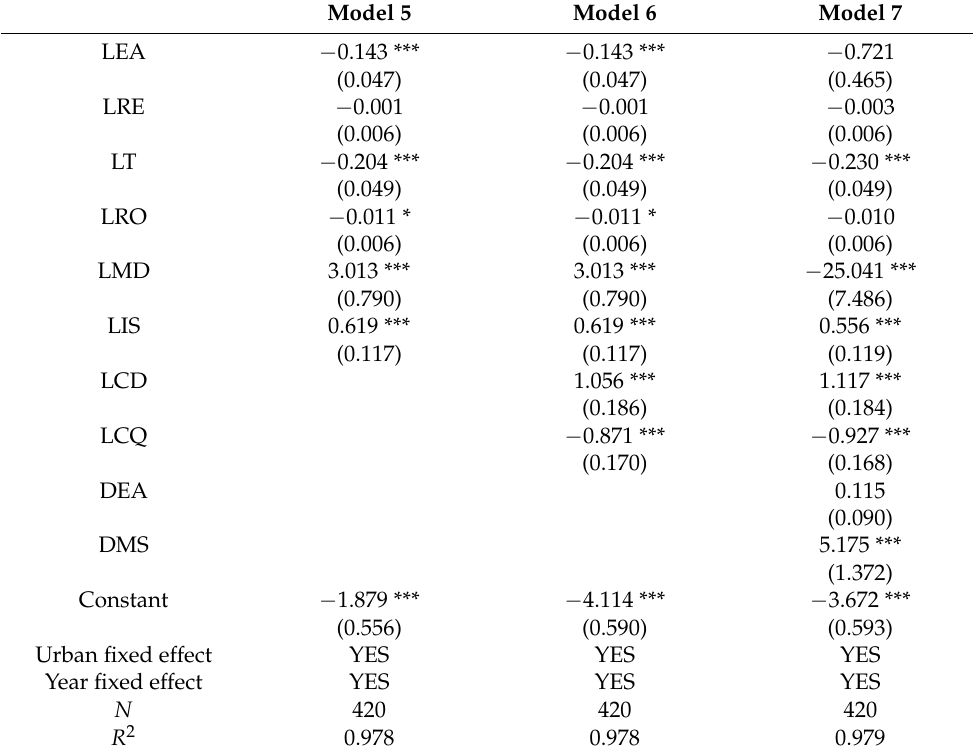
Table 5. Distinguishing the fixed effect of pulling